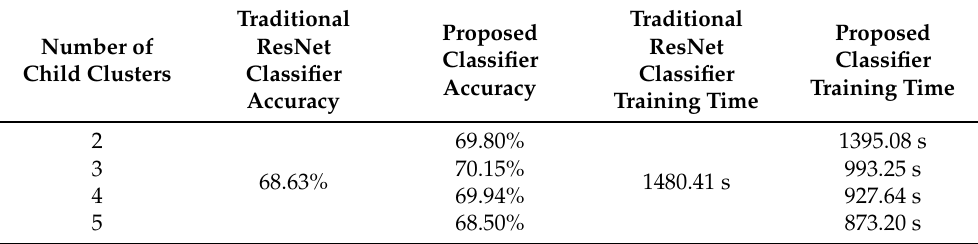
Figure 9. Training and validation loss of proposed classifiers with different child clusters. Table 4. Performance of proposed method with different child clusters.